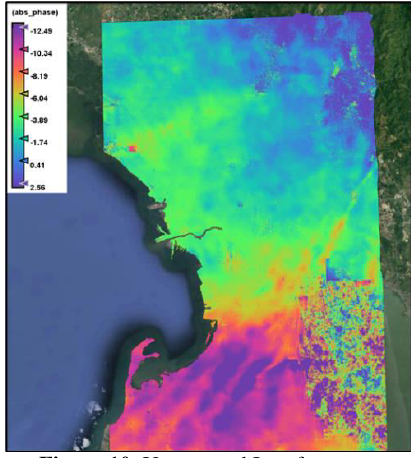
Figure 10. Unwrapped Interferogram